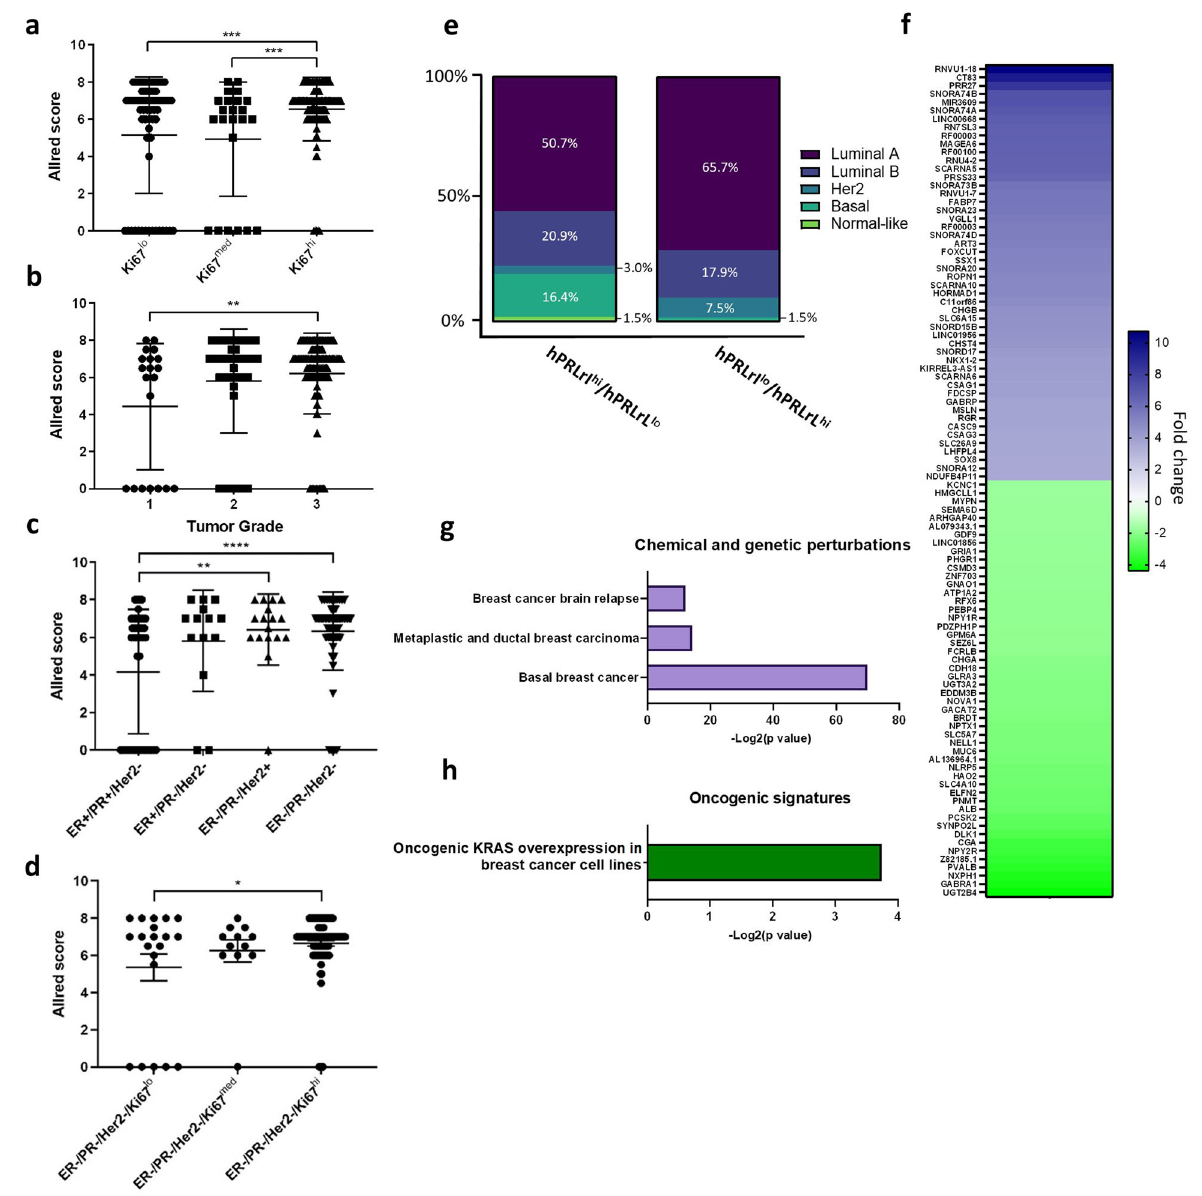
Fig. 7 Protein and transcript expression of hPRLrI in breast cancer clinical samples. hPRLrI protein in breast cancer clinical samples ( n = 250) was analyzed by tissue microarray (TMA) analysis. Allred score is re fl ective of both hPRLrI staining intensity and percent positivity. a Proliferative index, reported via Ki67 status, was assessed, as was b tumor grade and c hormone receptor status. d Proliferative index within the ER-/PR-/Her2- cohort was also analyzed. The hPRLrI:hPRLrL transcript ratio was also examined, using TCGA-reposited RNAseq data. e Breast cancer intrinsic subtype frequency was assessed for the hPRLrI hi /hPRLrL lo versus hPRLrI lo /hPRLrL hi ratio tertiles ( n = 67/tertile). f Differential gene expression patterns were characterized, with the heatmap displaying the top/bottom 50 differentially-expressed genes (DEGs), comparing the top/bottom hPRLr isoform ratio tertile. These DEGs were then analyzed via GSEA, looking within the g chemical and genetic perturbation and h oncogenic signatures gene sets. * p < 0.05, ** p < 0.01, *** p < 0.005, **** p < 0.001. Data is shown as mean ±